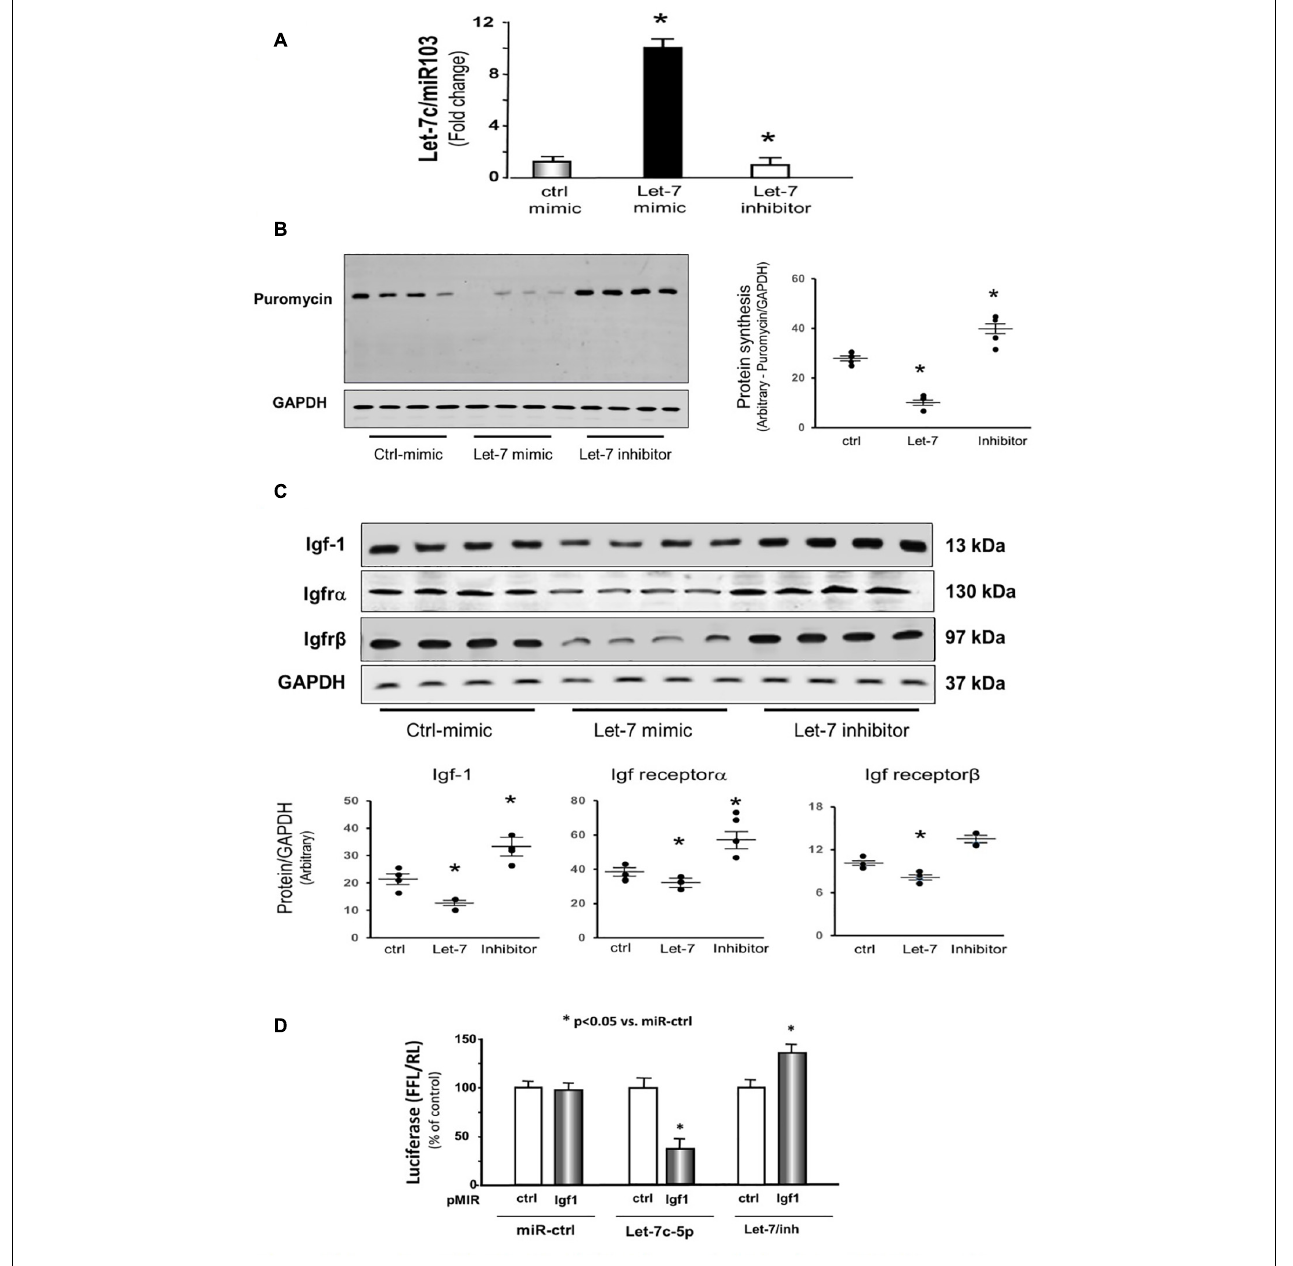
FIGURE 5 | Provision of let-7 inhibited Igf-1, Igfr α and Igfr β in cultured C2C12 myotubes. (A) Total RNA was isolated from C2C12 myotubes transfected with control/mimic, let-7-5p/mimic and let-7/inhibitor. The expression of let-7-5p was assayed by real time qPCR. The bar graph shows let-7-5p from different group compared with levels in control/mimic (defined as onefold). Results are normalized to miR103 (Bars: mean ± SE; n = 4/group; * p < 0.05 vs. control/mimic). (B) Protein was isolated from the C2C12 myotubes transfected with control/mimic, let-7-5p/mimic and let-7/inhibitor. Puromycin was added into cell culture medium (1 µ g final concentration) exactly 30 min before harvesting the cells. Puromycin in cell lysates was measured by Western blots. The point graph of incorporate puromycin into myotube shows the change of the density of puromycin protein normalized to their corresponding GAPDH protein ( n = 4/group; * p < 0.05 vs. sham). (C) Protein was isolated from the C2C12 myotubes transfected with control/mimic, let-7-5p/mimic and let-7/inhibitor. Igf-1, Igfr α and Igfr β in myotube lysates was measured by Western blots. The point graph showed the change of the density of each protein normalized to their corresponding GAPDH protein. Data is provided in arbitrary units. ( n = 6/group; * p < 0.05 vs. control/mimic). (D) C2C12 cells were transfected with luciferase pMIR–ctrl vector (white bars) or the vector containing the 3 (cid:48) -UTR of Igf1 (pMIR-Igf: black bars). Cells were co-transfected with control mimic (miR-ctrl), let-7c-5p or let-7 inhibitor. Luciferase activity in cells that received the pMIR–ctrl with miR-ctrl was designated as the 100% (far left white bar). The other bars show the response to let-7 expressed as a percent of this control. Triplicate determinations were made in each condition and each experiment was repeated twice; the firefly luciferase (FFL) results were normalized by renilla luciferase (RL) activity. Data: mean ± SE; n = 9; * = p < 0.05 vs. pMIR-ctrl +